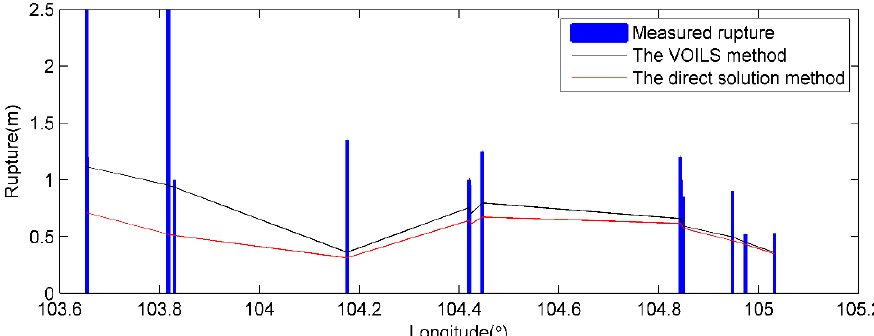
Figure 12. Comparison of the derived vertical displacements with the surface rupture measurements (The blue bar represents the measured rupture from field investigations (Xu et al., 2009) [50]. The black and red lines represent the displacements by making subtraction between the derived deformation on hanging wall and footwall from the VOILS method and the direct solution method, respectively.).